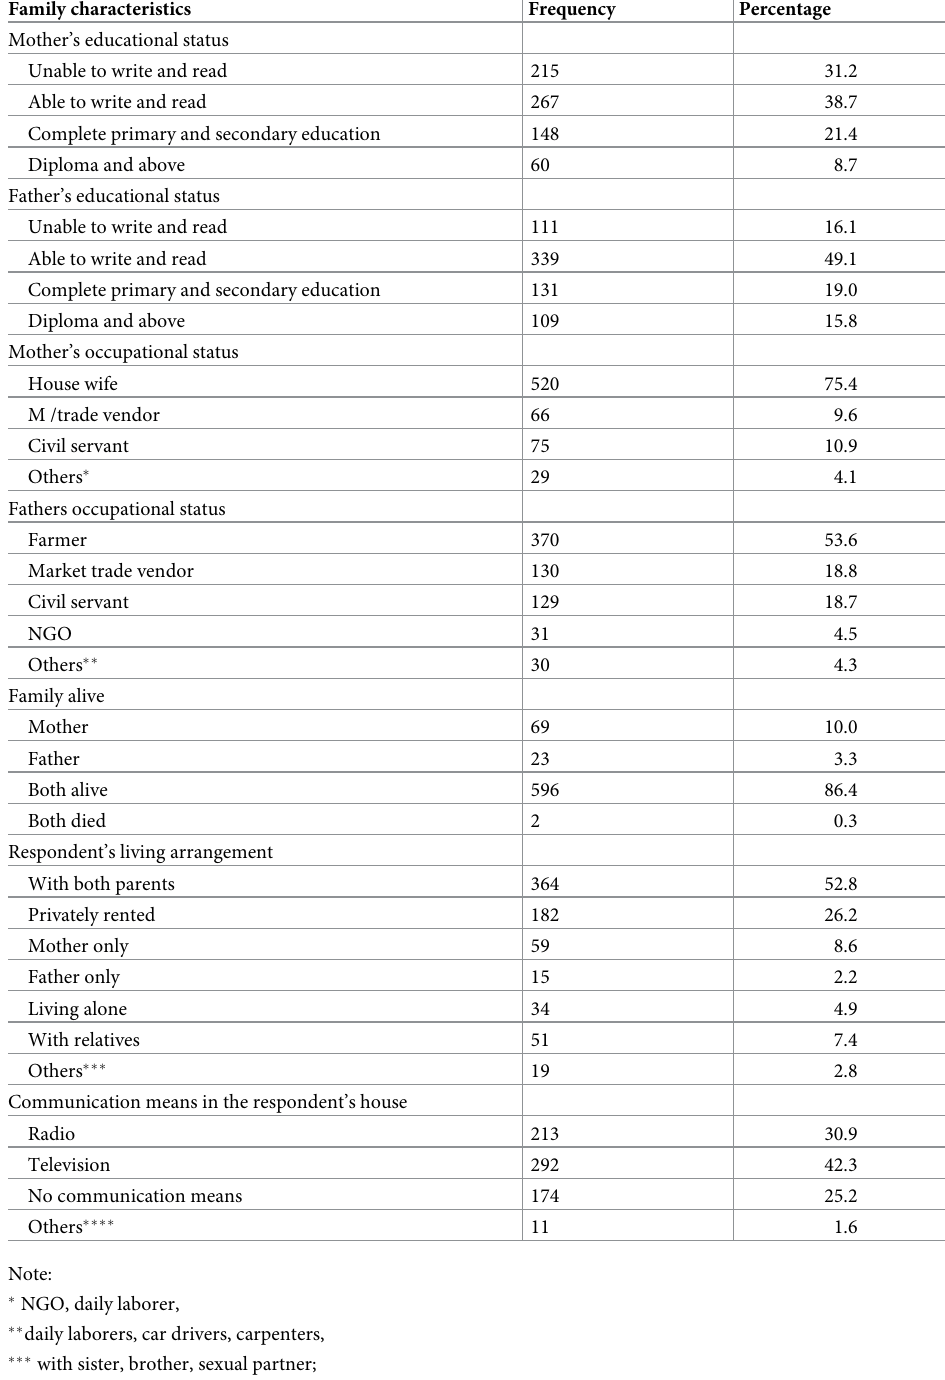
Table 2. Family characteristics, living arrangements and communication means of students in Debre Tabor town, Northwest Ethiopia,